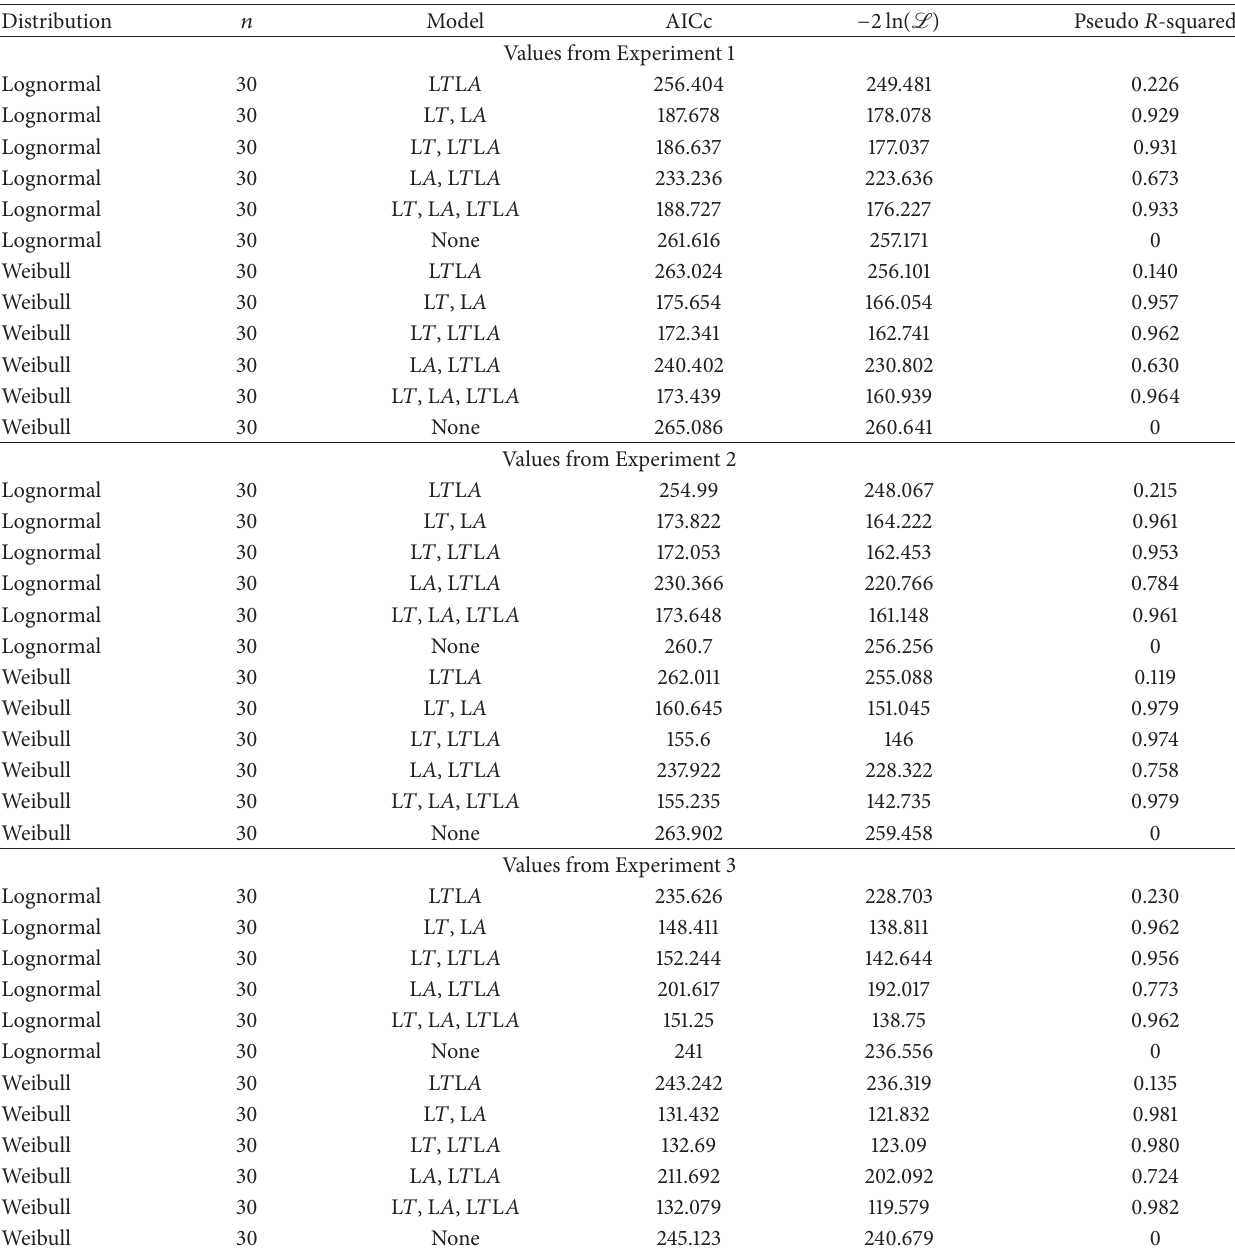
Table 3: LIFEREG procedure analysis in SAS 9.3 using lognormal and Weibull distribution utilizing observed logarithmic values of 𝑇 , 𝑎 𝑤 , and a logarithmic interaction term of L 𝑇 × L 𝑎 𝑤 and MFD in three individual